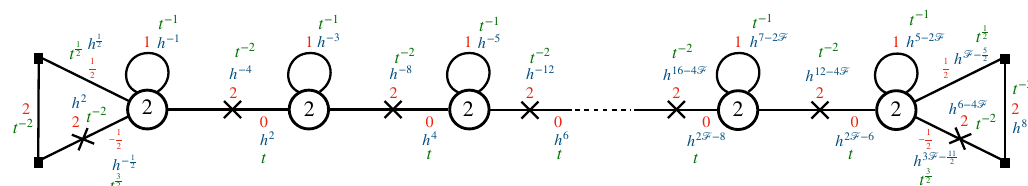
= F > 2 for the case of N = 2. Figure 6: The Lagrangian for the sphere with n L The number of gauge nodes is F − 2. Here t is the fugacity for the Cartan of SU ( 2 ) L and the 6d R-charges are written in red. The fugacity h is for an additional U ( 1 ) symmetry that will be related to SU ( 2 ) in the text. One should turn on all the ISO gauge invariant superpotentials consistent with the charges denoted in the